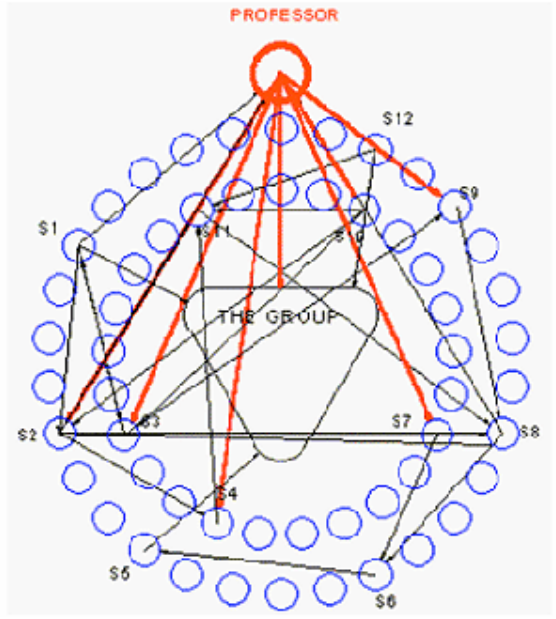
Figure 6. Interaction Diagram derived from a video of a F2F September, 1999 AHSC230 class.